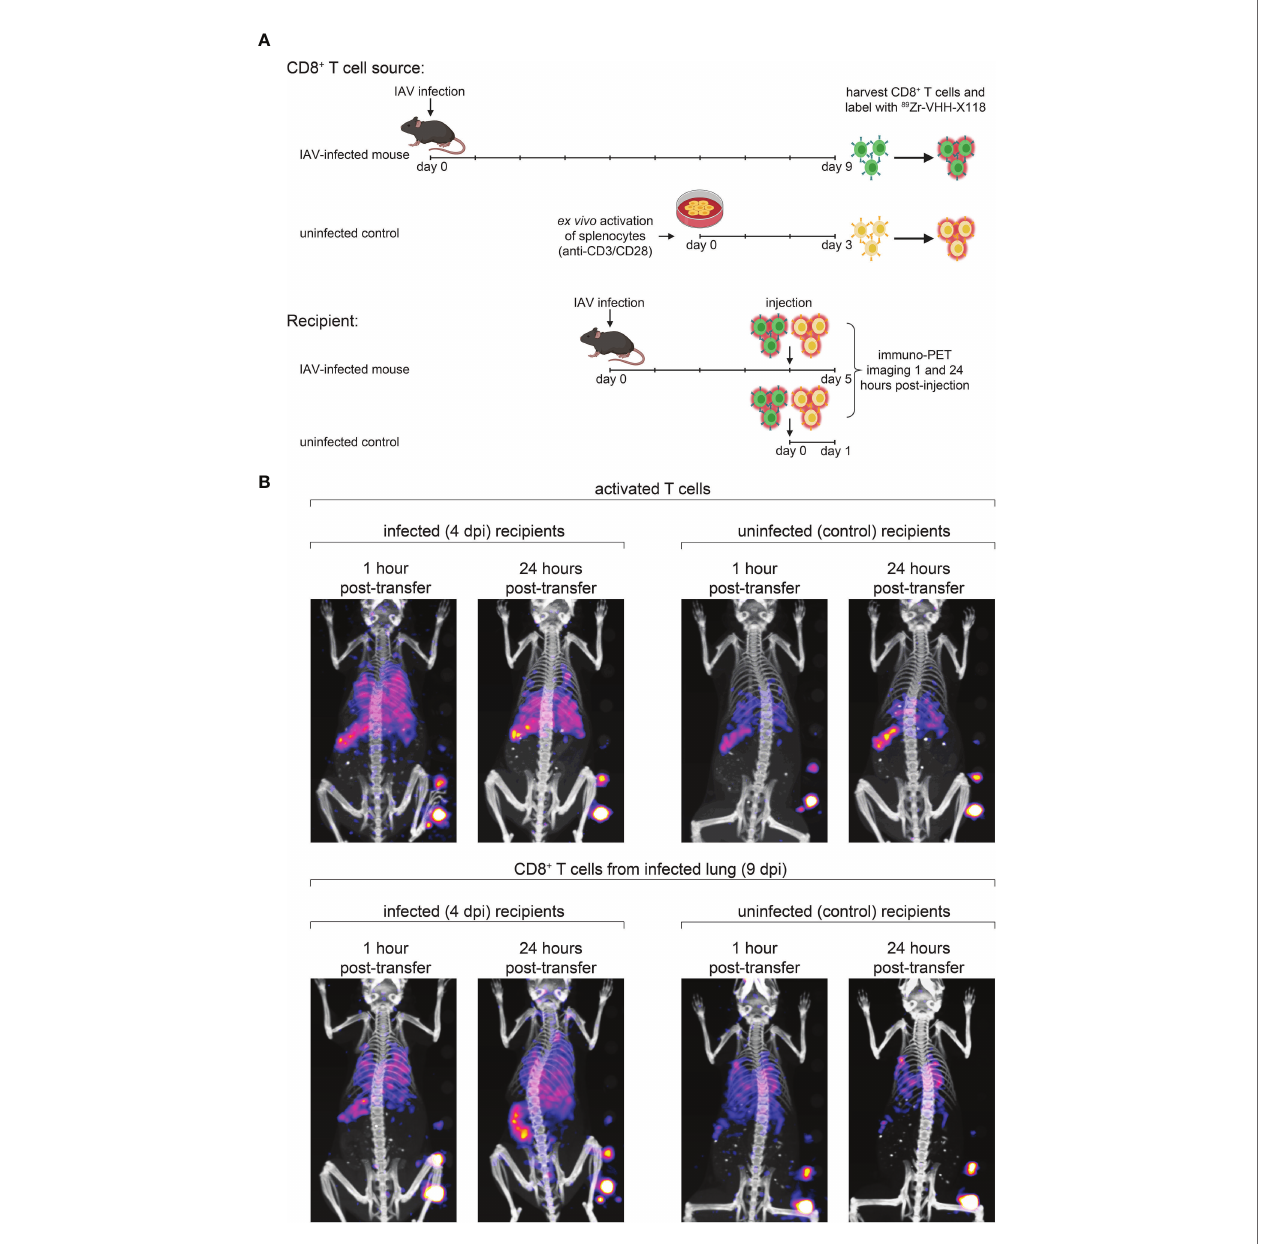
FIGURE 5 | Distribution of Transferred CD8 + T Cells Relies on the Site of T Cell Maturation and Local In fl ammatory Environment. (A) Schematic depicting CD8 + T cell transfer experiments. Donor mice were infected with IAV WSN/33 and CD8 + T cells were harvested from the lungs at 9 dpi. Harvested CD8 + T cells were ex vivo labeled with 89 Zr-VHH-X118 and injected into day 4-infected or uninfected mice. As a control, CD8 + T cells were puri fi ed from naïve splenocytes of uninfected mice, ex vivo activated, and injected into day 4-infected and uninfected mice. Mice were immuno-PET imaged 1 hour and 24 hours post-transfer. (B) Day 4-infected or uninfected recipient mice, shown face down, were immuno-PET imaged at the indicated times post-transfer of 89 Zr-labeled T cells from the indicated donor source. A standard with set amounts of radioactivity in 2-fold dilutions starting at 0.4 m Ci is on the lower right side of each image. Data are representative of 2